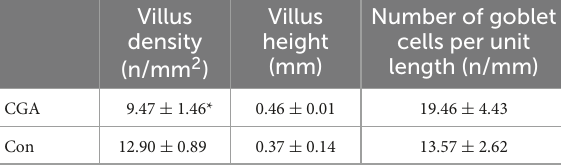
TABLE 3 Effect of chlorogenic acid on intestinal morphology of Carassius auratus.